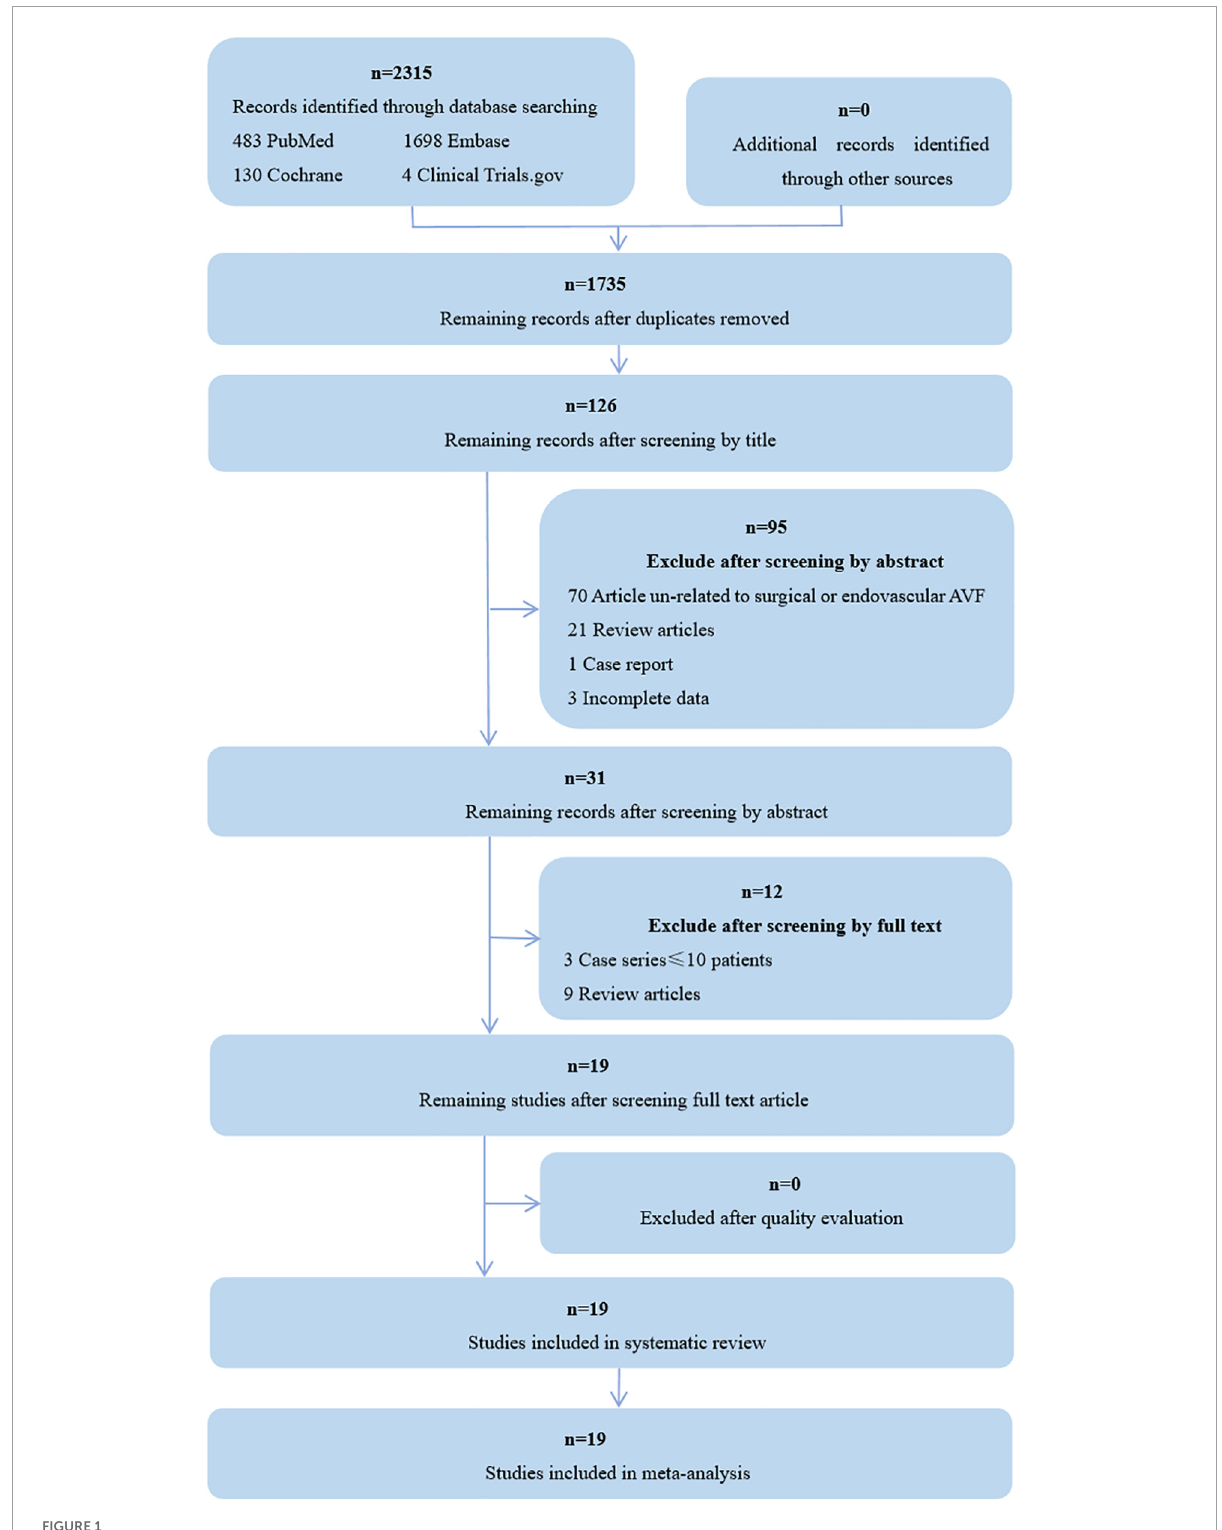
FIGURE1 Flow diagram shows studies selection. AVF, arteriovenous